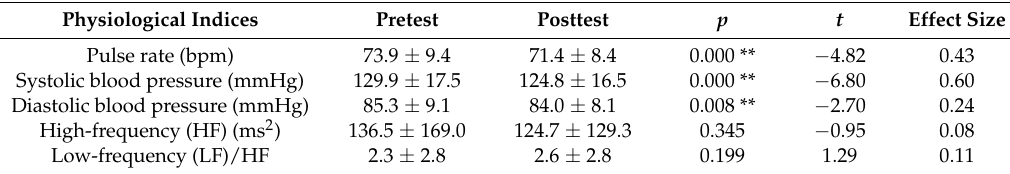
Table 2. Effect of the forest bathing on physiological indices.